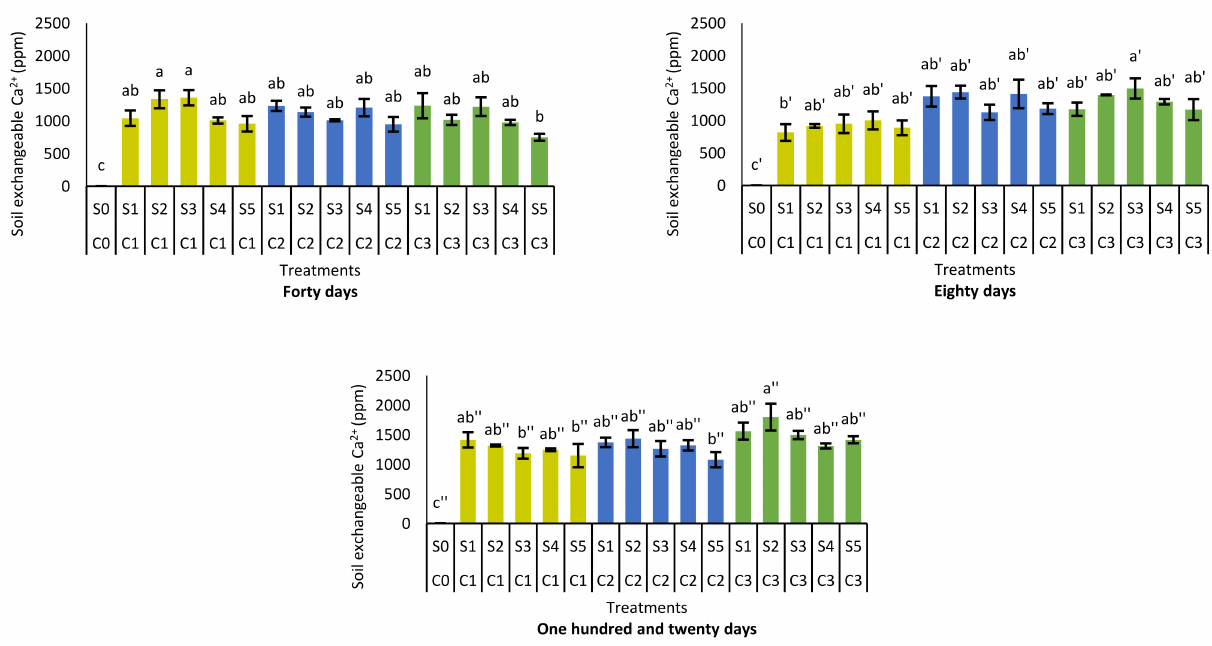
Figure 2. Soil exchangeable calcium in relation to combined use of Calciprill and sodium silicate at forty, eighty, and one hundred and twenty days incubation. Different letters indicate significant mean differences using Tukey’s HSD test at p ≤ 0.05. The error bars refer to ± standard error of three replicates. Small letters, small letters with ’, and small letters with ” indicate mean comparison at forty, eighty, and one hundred and twenty days incubation,